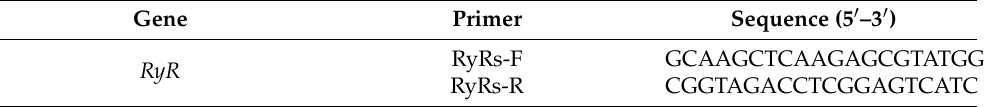
Table 2. Primers of partial RyR for